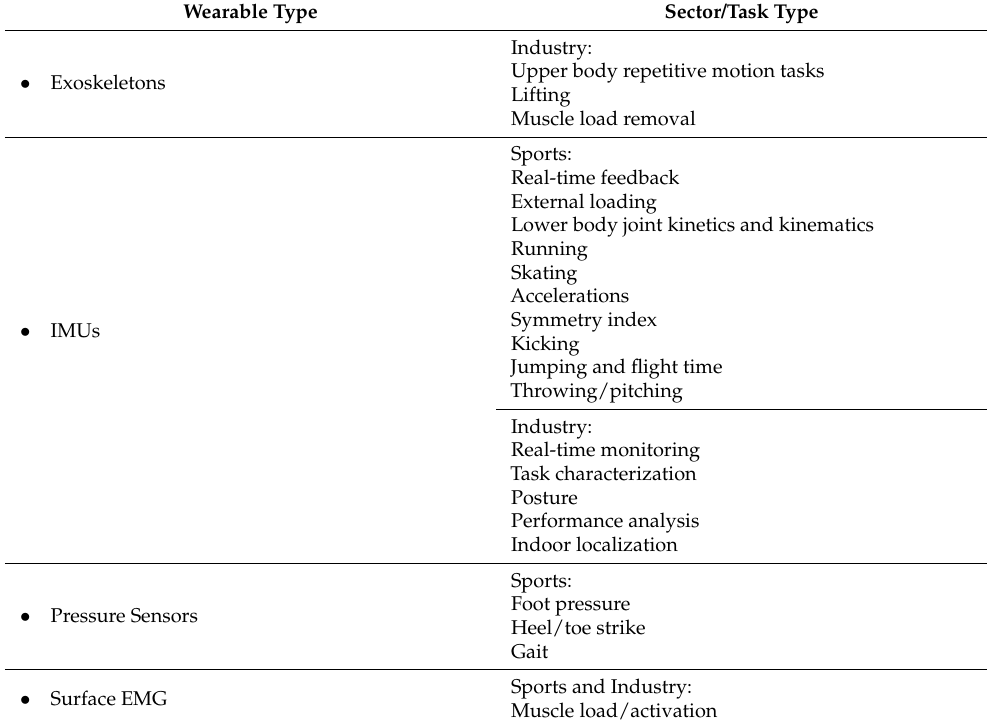
Table 2. Wearable biomechanical types and applications in sports and industry key